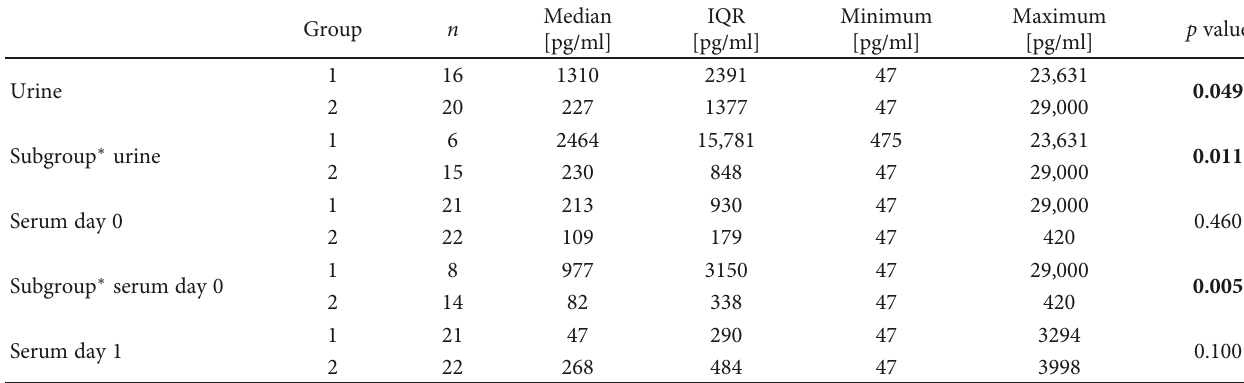
Table 2: I-FABP of serum and urine samples.